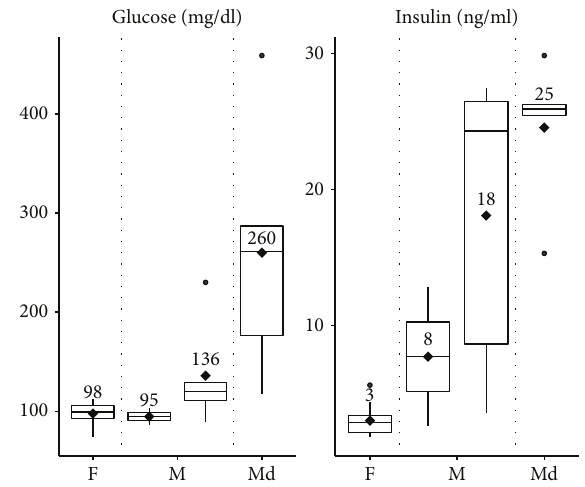
Figure 2: Identi fi cation of nondiabetic, prediabetic, and diabetic subjects based on blood glucose and plasma insulin concentrations. Plasma glucose and insulin levels were separately analysed based on the HCPC-derived clusters for nondiabetic females (F), non- and prediabetic male mice from clusters 1 and 2 (M), and diabetic male mice from cluster 3 (Md). Rhombuses depict mean values.